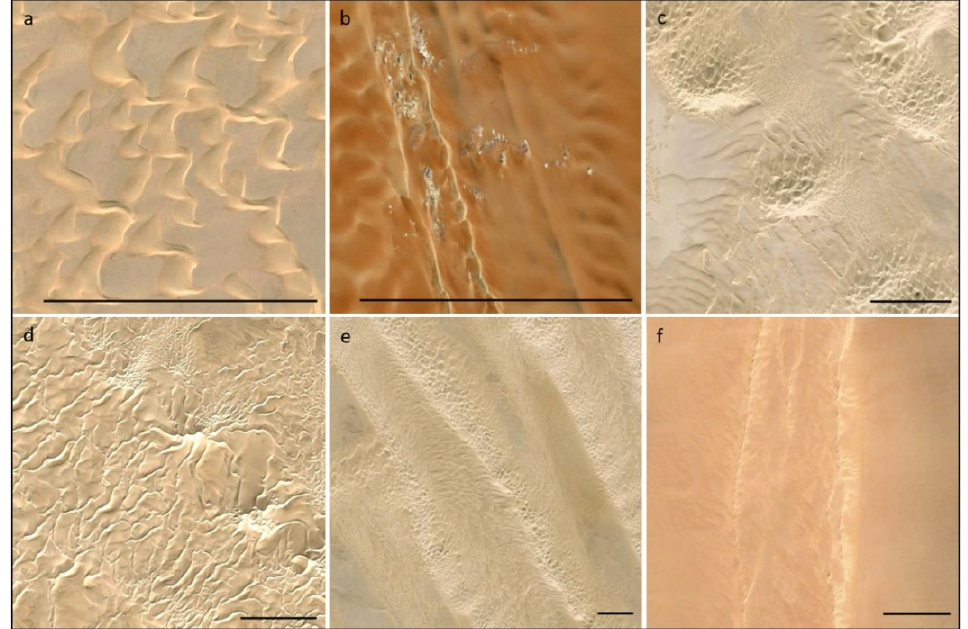
Figure 3. Examples of dunes and dune pattern in Egypt. ( a ) A section of a barchan field in the southern part of the North Sinai Sand Sea. ( b ) Megaripples along the eastern margins of the Central Section of Ghard Abu Moharik Sand. ( c ) Domal dunes with rippled surfaces at the southern margins of South Qattara Sand Sea. ( d ) Star dunes at the eastern fringe of the South Qattara Sand Sea. ( e ) Wide linear dunes (silk) with rippled surfaces, South Qattara Sand Sea. ( f ) Draa (Pleistocene megadune) with superimposed Holocene linear dunes (silk), southwestern part of the Great Sand Sea. All satellite images are orientated to the north. Each scale bar is equal to 1 km. Source: Google Earth image © 2013 CNES/Airbus.